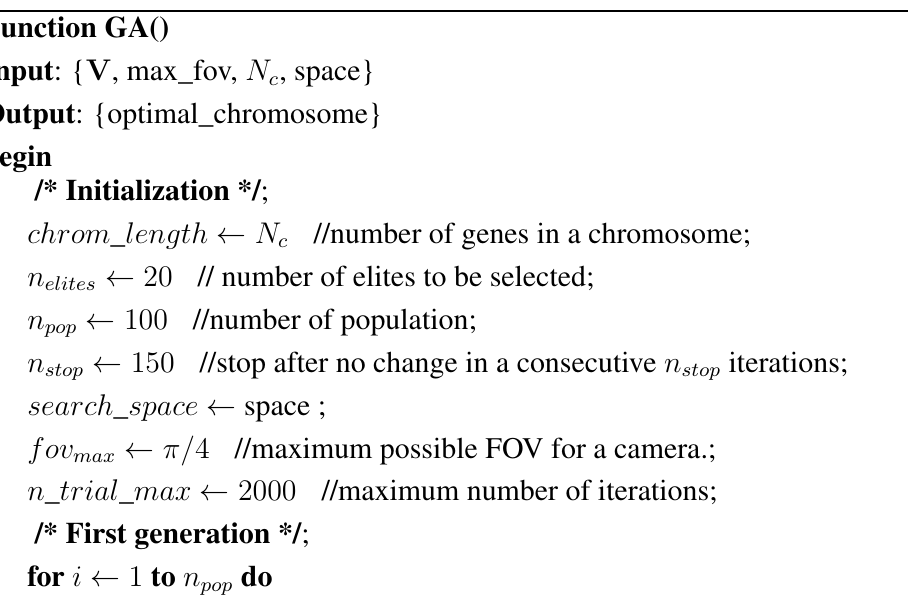
ALGORITHM 5 : Genetic algorithm to search for an optimal solution for camera placement